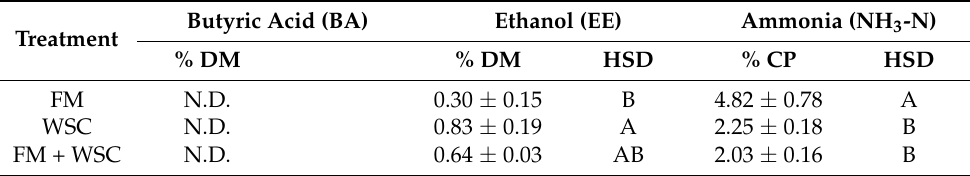
Legend to Table 6: Mean of measured values ( n = 3) ± standard deviation (SD). All parameters were recalculated to sample dry weight (DM); ammonia content was expressed as % of crude protein (CP). Different letters indicate significant differences ( p < 0.05) among individual variants in the specific parameter. FM—fodder mallow, WSC—white sweet clover, N.D.—not